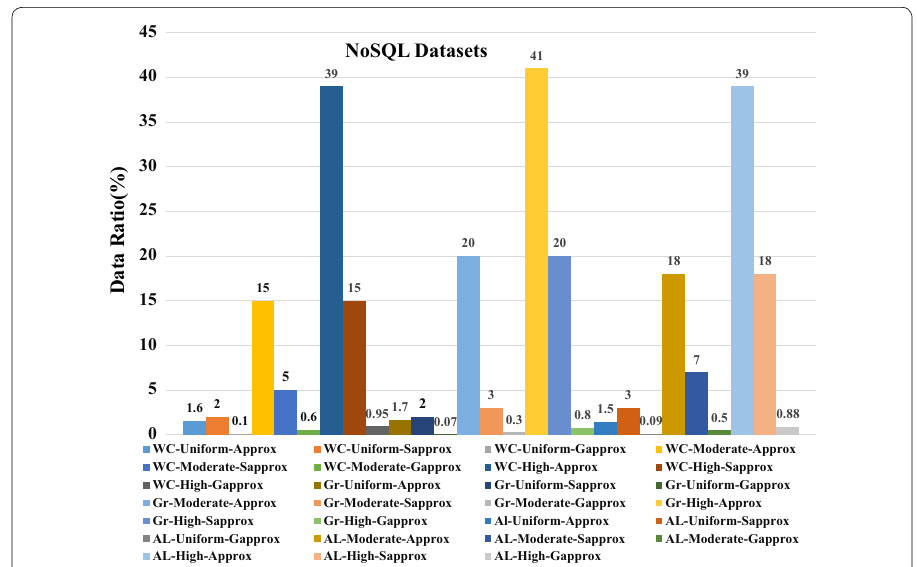
Fig. 18 Impact of data variety on the sampling overhead (NoSQL datasets)